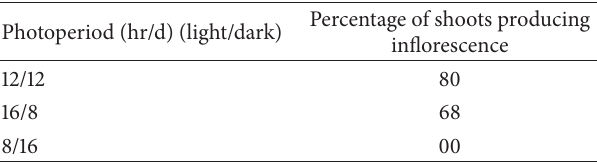
Table 3: Effect of photoperiod on in vitro flowering of R. pectinata on half strength MS medium after 4 weeks of